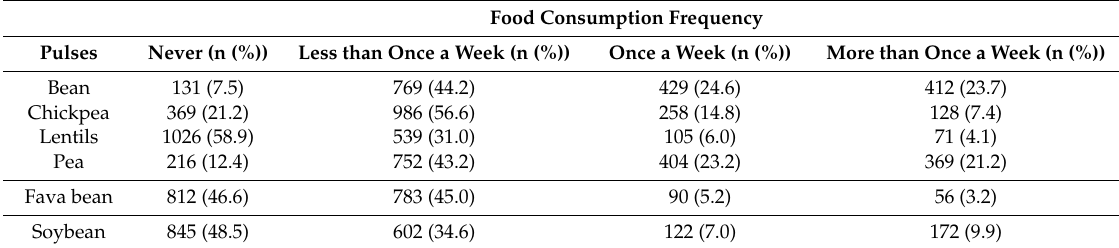
Table 3. Consumption frequency of common pulses in Portuguese